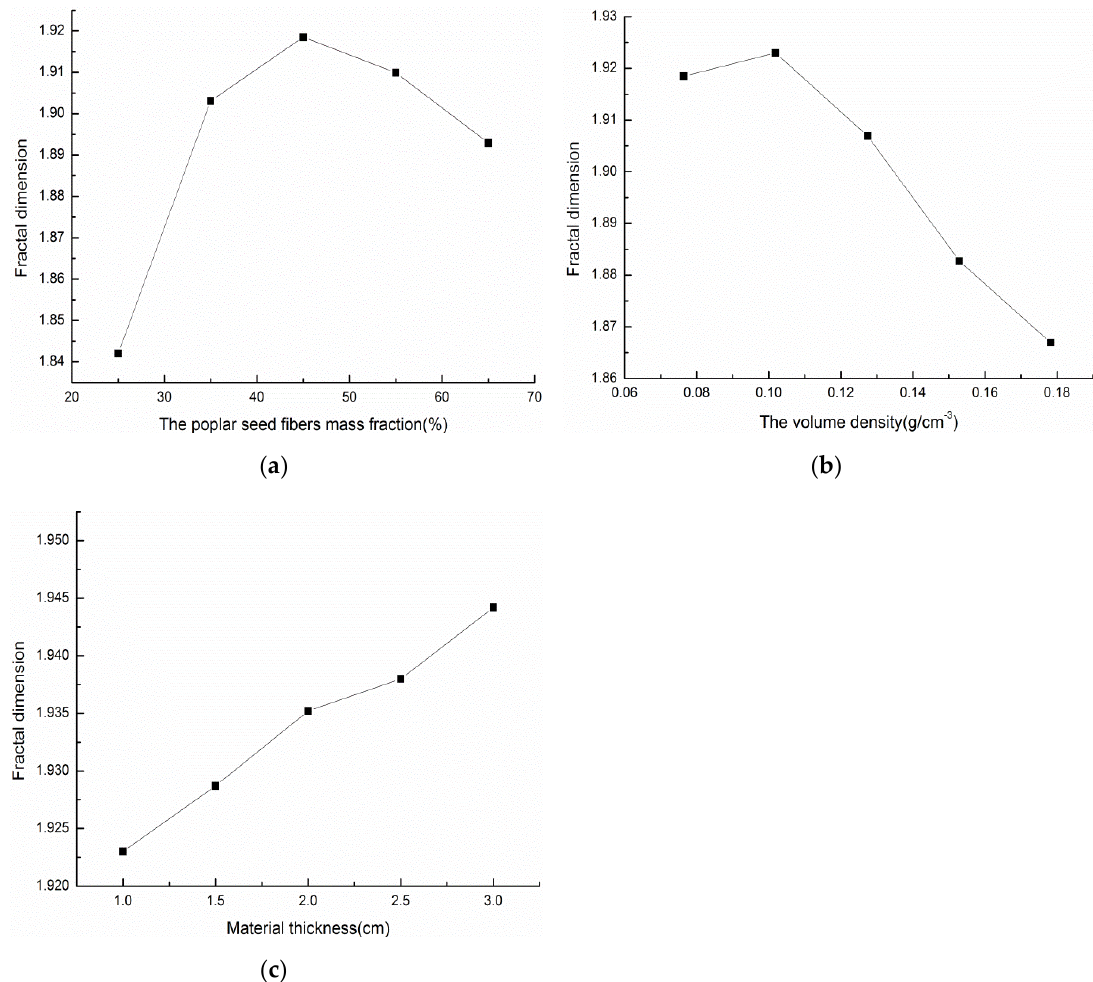
Figure 10. Relationship between fractal dimensions and mass fraction of poplar seed fiber, material density and material thickness: ( a ) Relation between the mass fraction of poplar seed fibers and fractal dimension. ( b ) Relationship between material density and fractal dimension ( c ) Relationship between material thickness and fractal dimension.